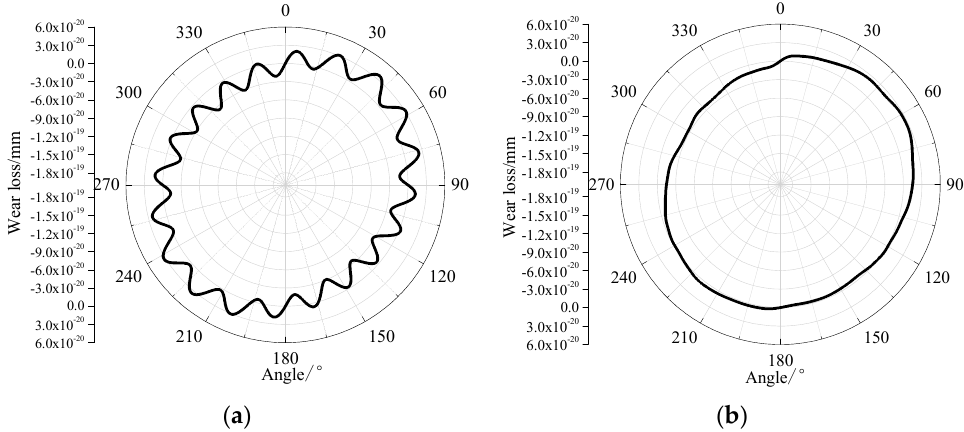
Figure 13. Results of wear loss along the circumferences of the two wheels with rolling of 50 circles. ( a ) Flexible wheelset and ( b ) Rigid wheelset.